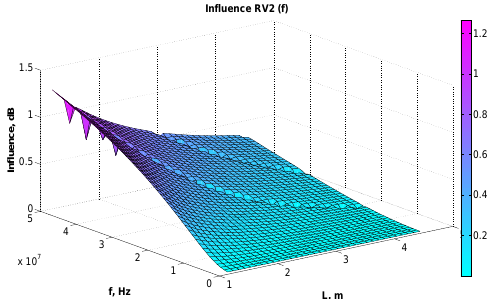
Figure 13: Influence of f parameter (RV2).